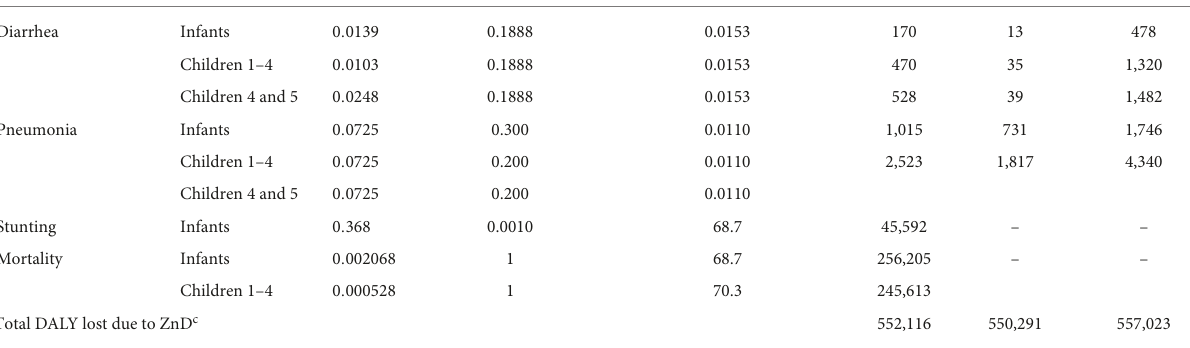
TABLE 1 Calculated DALY lost attributable to ZnD under optimistic and pessimistic scenarios among children in Ethiopia. Outcomes of ZnD Age